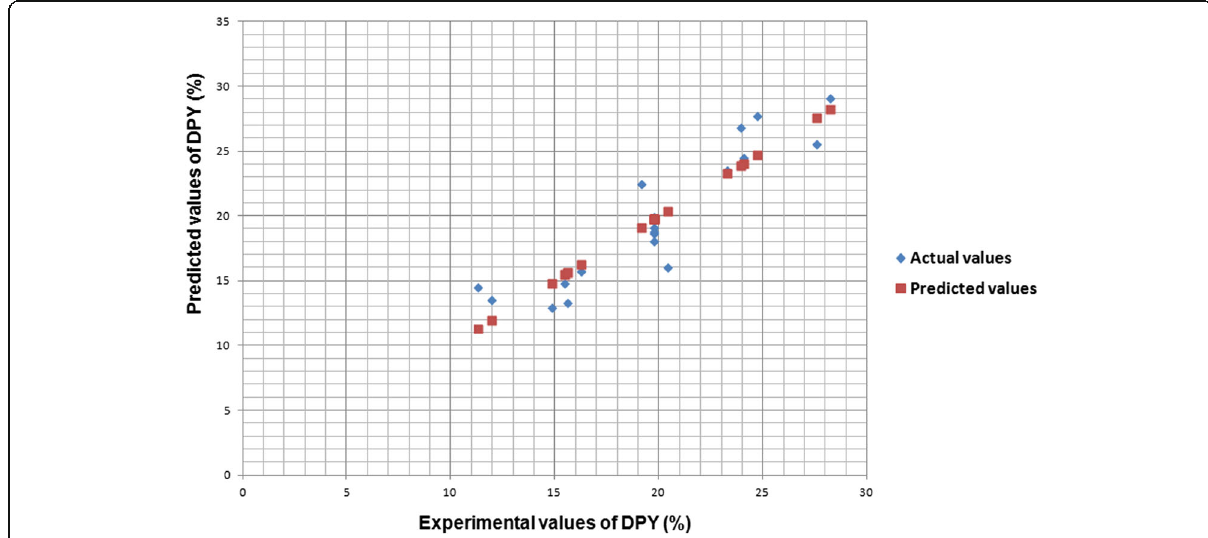
Fig. 6 Predicted and actual values for dried pectin yield